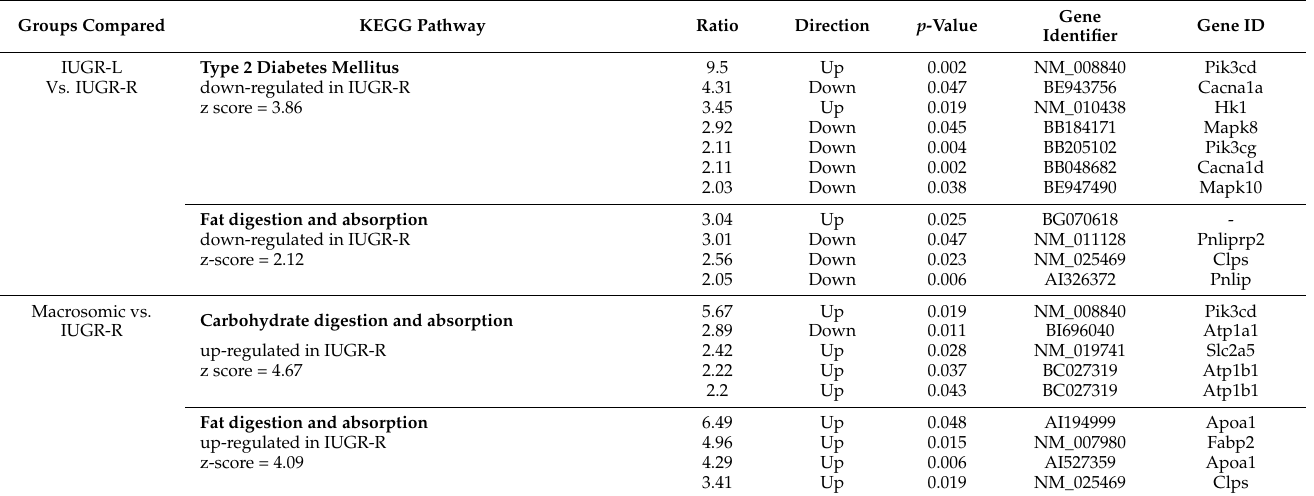
Figure 9. Differentially expressed genes. Statistical comparisons were between either IUGR-L and IUGR-R animals or between IUGR-R and Macrosomic animals. * p < 0.05 compared to IUGR- R. p values are Benjamini-Hochberg-corrected; uncorrected p values are all < 0.001. Values are mean ± SEM. Table 1. KEGG Pathways differentially impacted by growth. Statistical comparisons were between either IUGR-L and IUGR-R animals or between IUGR-R and Macrosomic